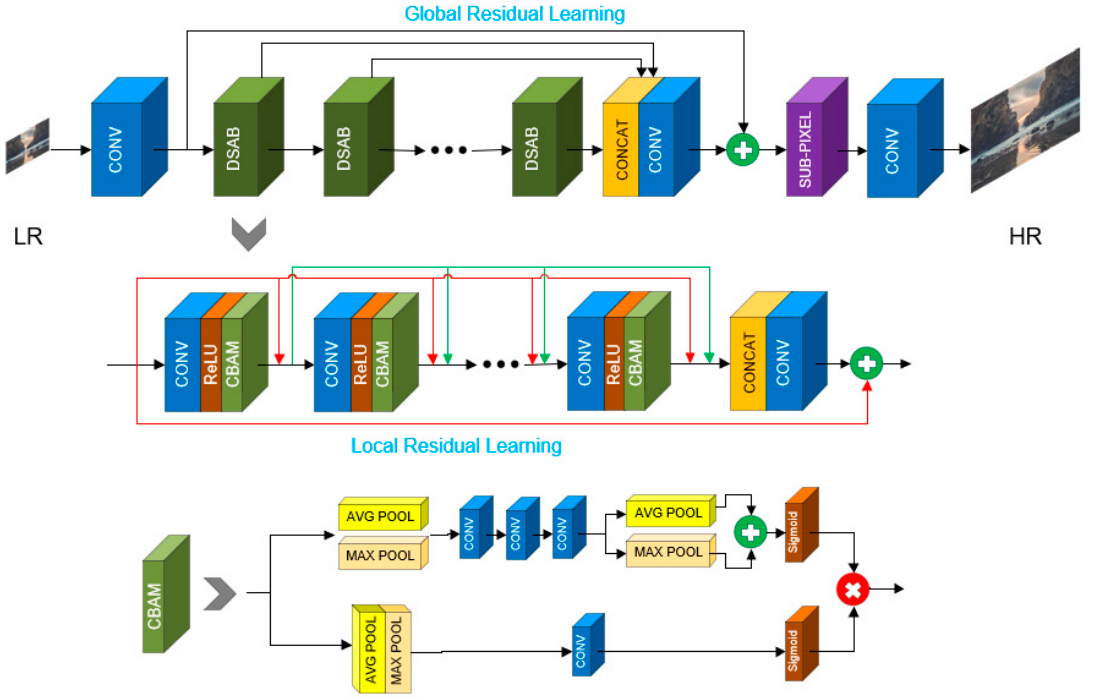
Figure 18. DSAN network structure (DSAB stands for dense space attention block).